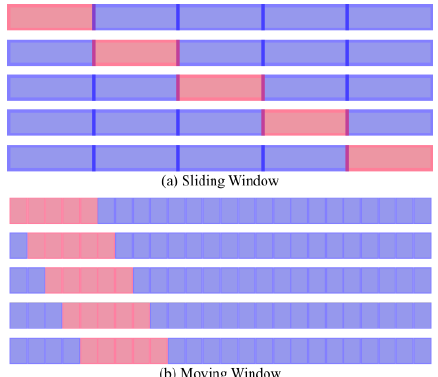
Figure 3. The difference between sliding and moving